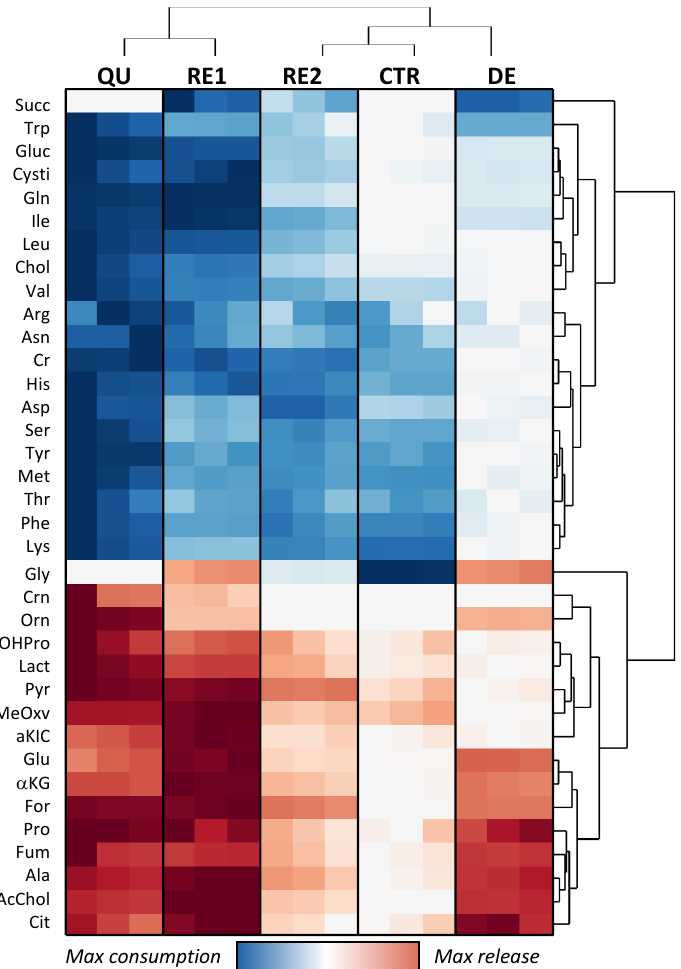
Figure 3. Heatmap of the consumption and excretion rates of control PC3 and during the successive phases of CRAC. Abbreviations used: for: formate, Fum: fumarate, OAcChol: